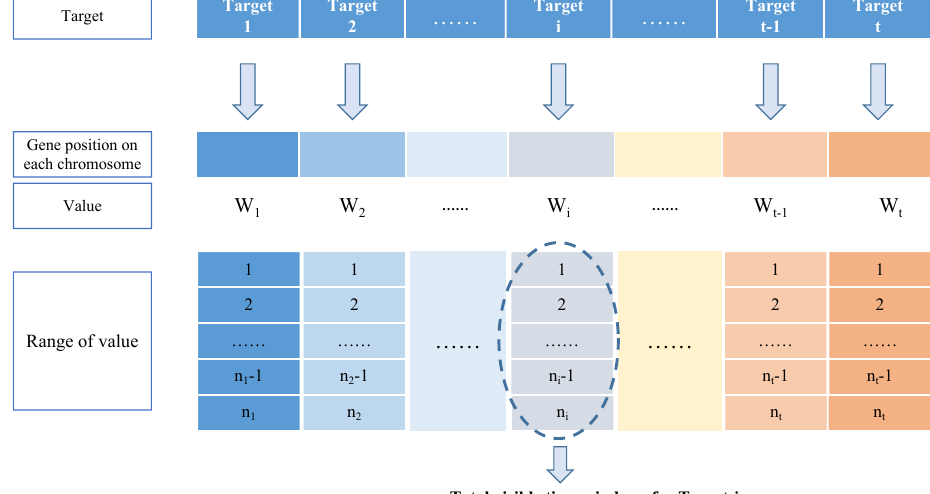
Figure 4. Real coding format of